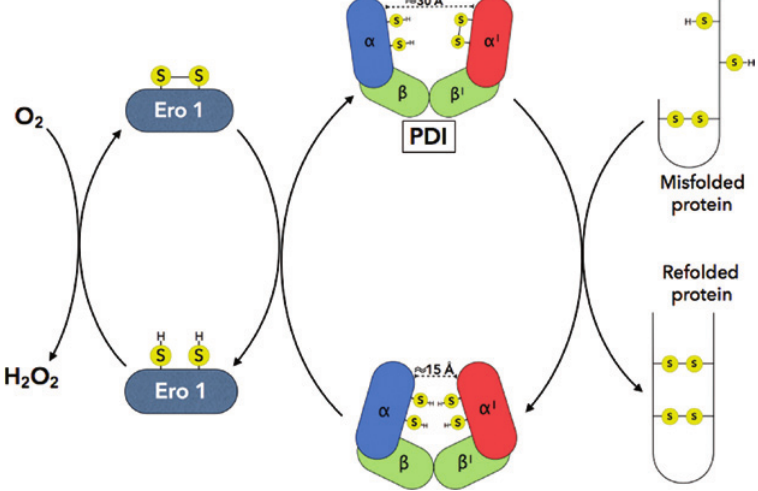
Figure 5: Protein disulphide isomerase as a redox-chaperone. Oxidation of PDI increases the distance between the two active sites, exposing a larger surface area of the hydrophobic region, promot- ing the binding of unfolded proteins. Oxidation of the substrate, introducing disulphide bonds, results in the reduction of PDI, where the structure now adopts a more compact conformation. Once correctly folded, the substrate is